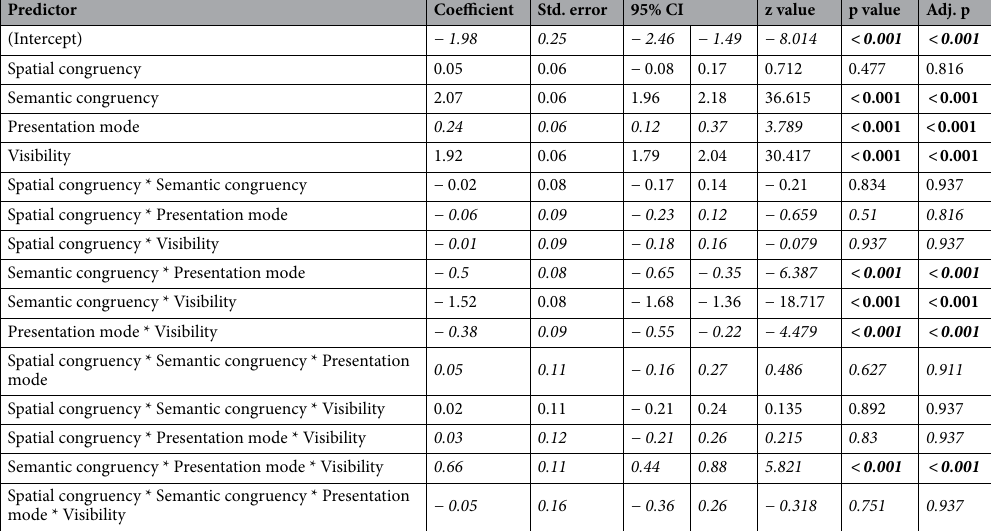
Table 3. Summary of the GLMM fitted for Picture identification accuracy in Experiment 2 (masked pictures). The results pertaining to our hypotheses are shown in roman, the remaining results in italics. Bold indicates significant p-values.